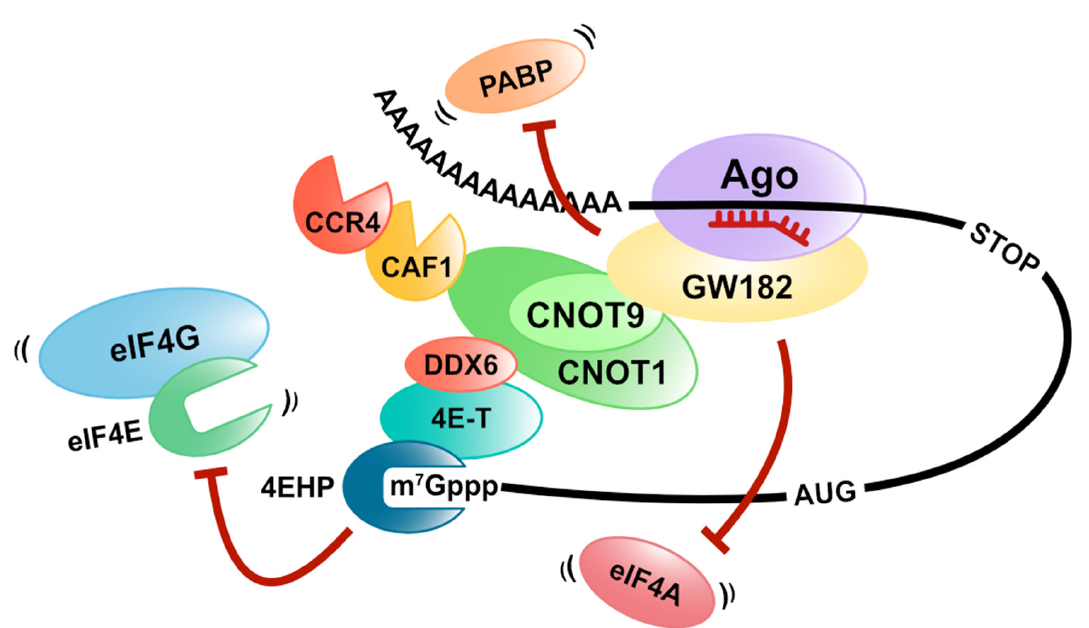
Figure 4. MiRNA-mediated translation repression. MiRISC (including GW182) represses the translation in a deadenylation-independent manner via the dissociation of PABP, eIF4As, or eIF4E.